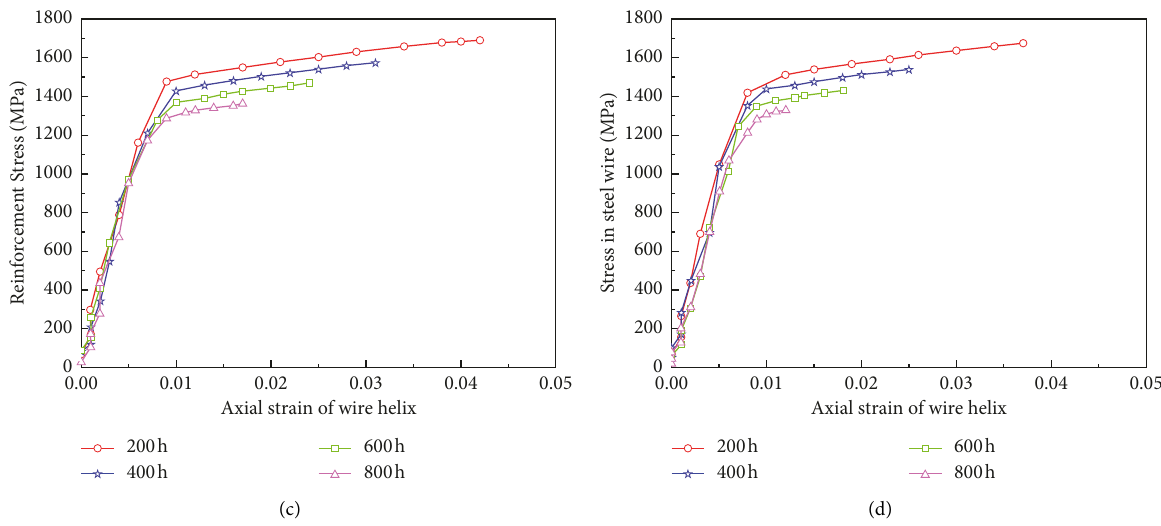
Figure 11: Changes in mechanical properties of steel wire at different depths of pitting corrosion.